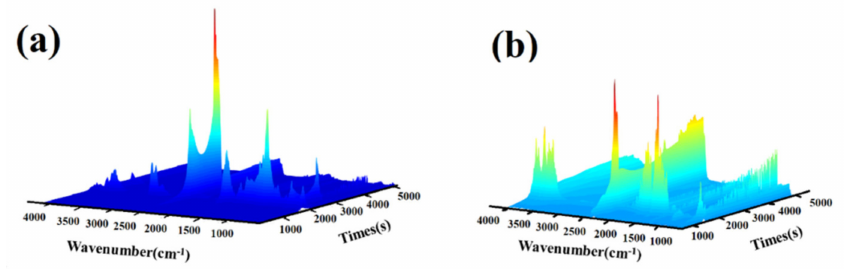
Figure 13. TG − IR 3D images of gaseous compounds during thermal degradation process for control ( a ) and treated ( b ) lyocell fabrics.